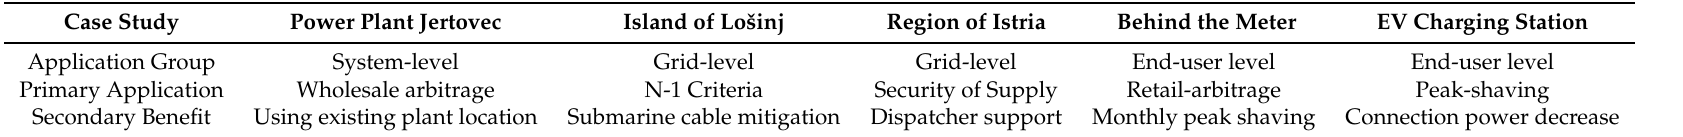
Table 1. Overview of selected case studies for battery